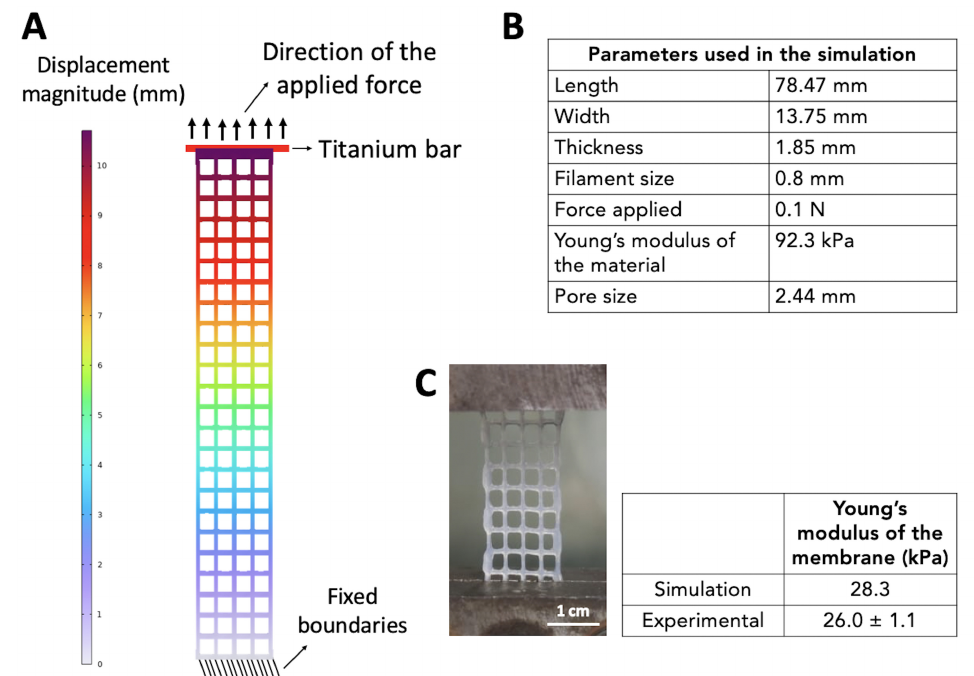
Figure 6. Simulation and experimental results of the tensile test of the square membranes. ( A ) Model of the square membrane after elongation under an applied force of 0.1 N. ( B ) Table summarizing the parameters used in the simulation. ( C ) Representative photograph of a square membrane during a tensile test and table summarizing the simulation and experimental results (n =